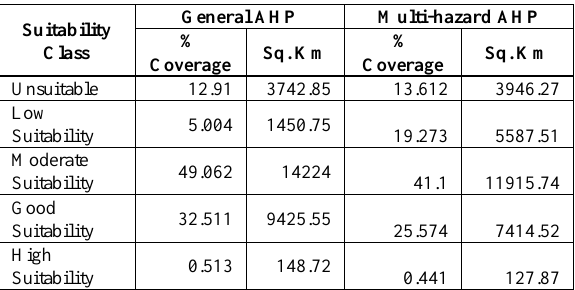
Figure 5. Residential land-use suitability map of Multi-hazard AHP Table 1. Residential land-use coverage for different degree of